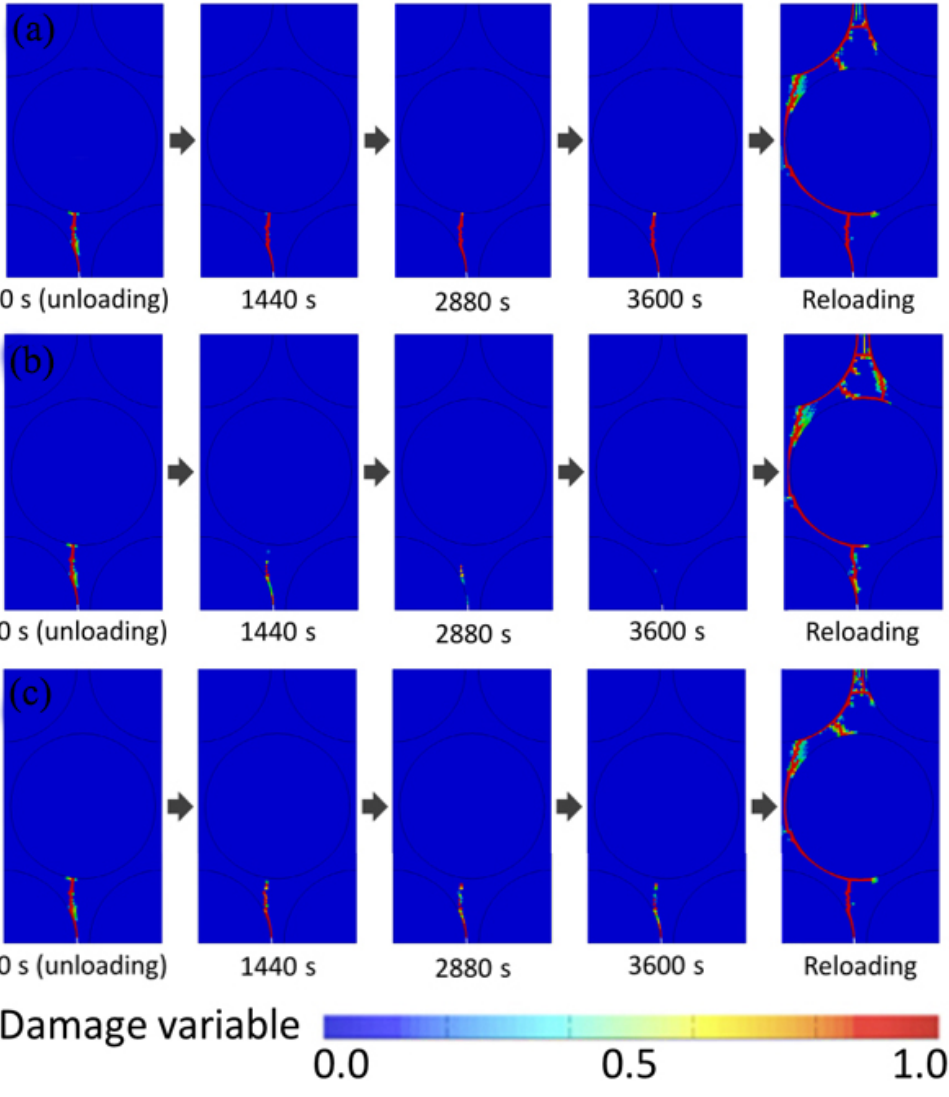
Figure 7. Time series snapshots for the damage-healing processes during the FE analysis: ( a ) T h = 1523 K, a O2 = 0.21; ( b ) T h = 1623 K, a O2 = 0.21; ( c ) T h = 1623 K, a O2 = 0.05 [54].